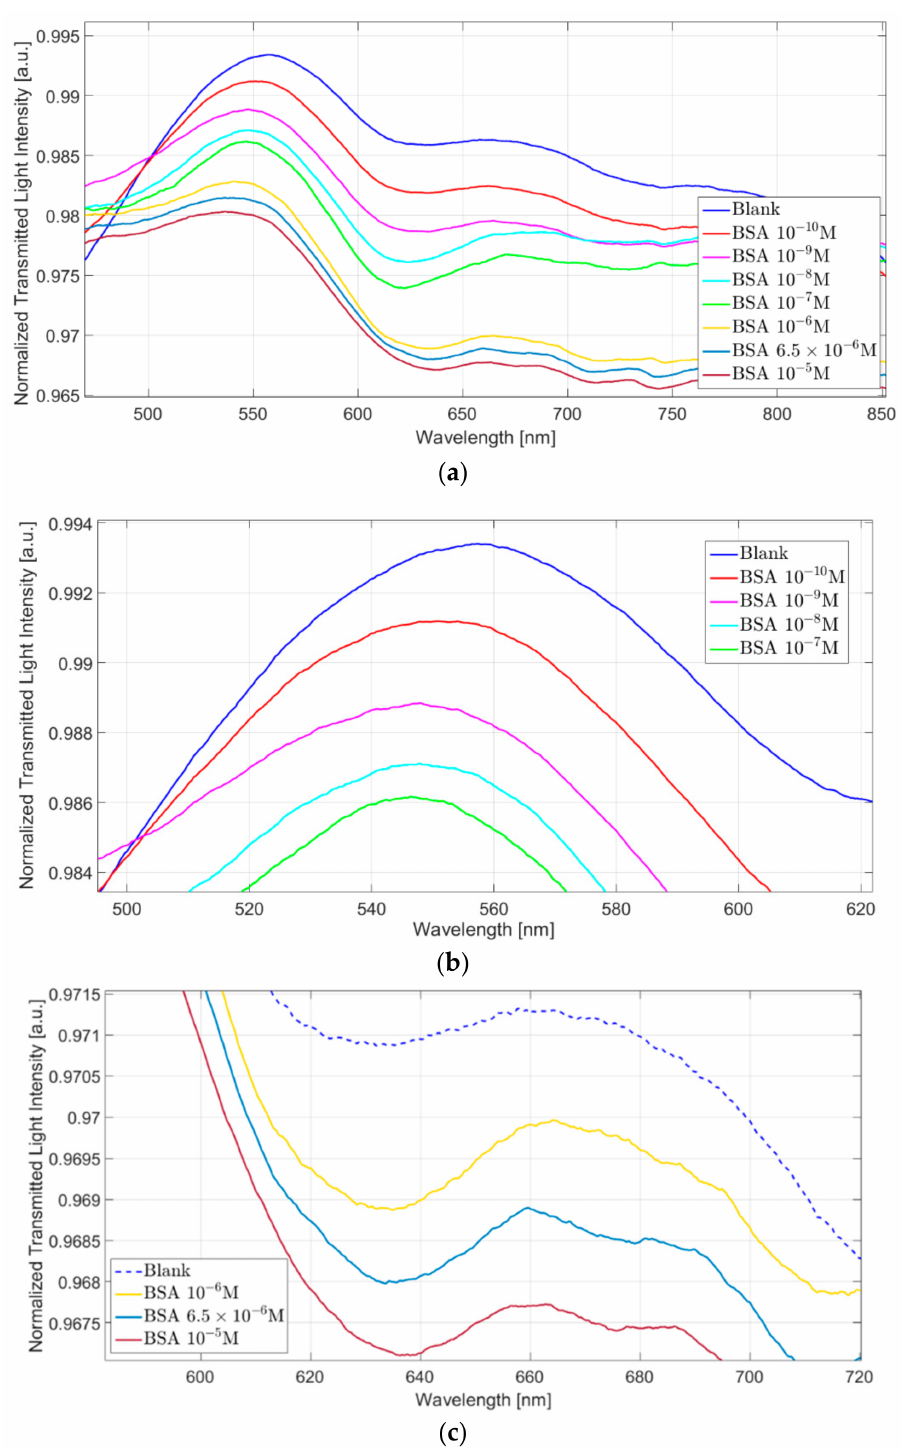
Figure 5. ( a ) Plasmonic spectra at varying of the BSA concentration (0–10 − 5 M) relative to “GNG- based longitudinal” configuration. Zoom of the resonance wavelength area relative to ( b ) peak at 550 nm and ( c ) peak at 630